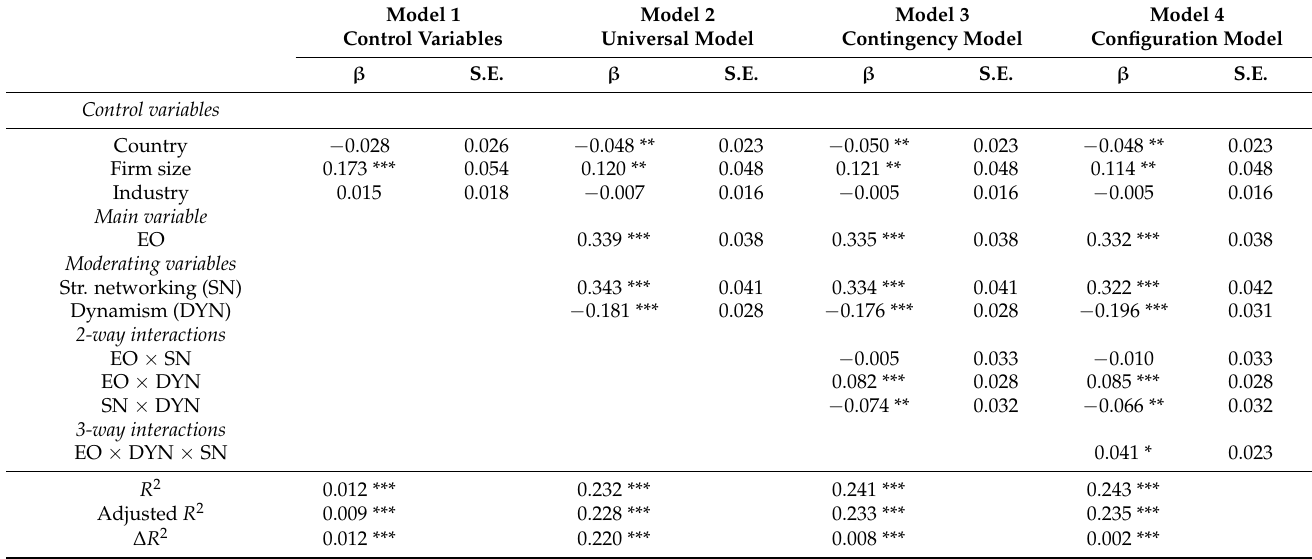
Table 3. Business performance: universal, contingency, and configurational model (n =